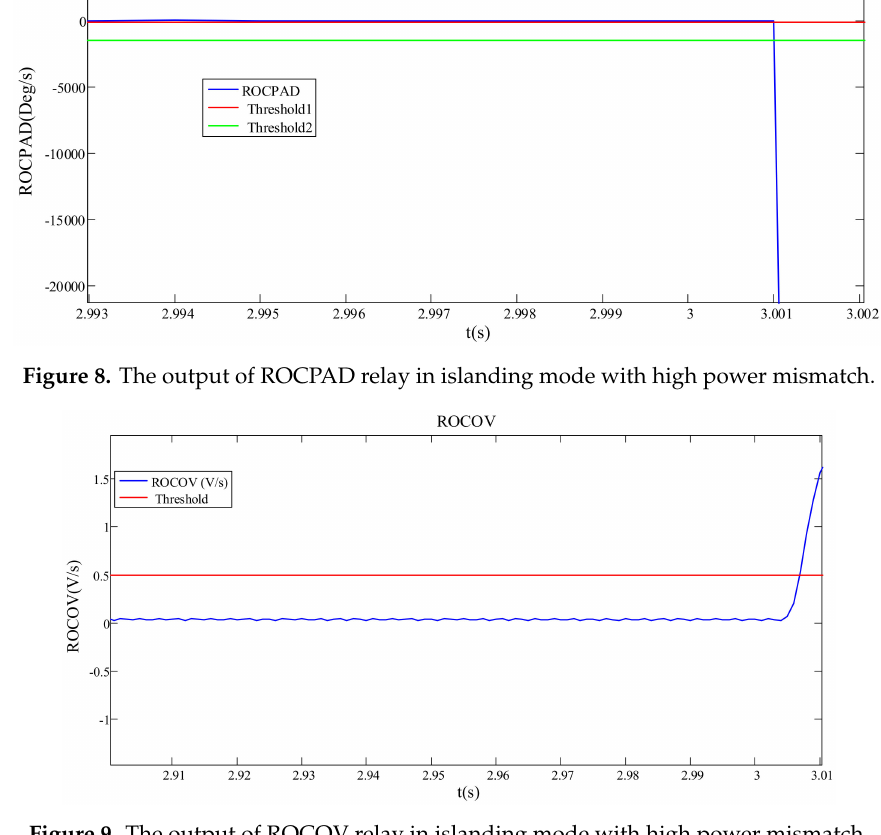
Figure 9. The output of ROCOV relay in islanding mode with high power